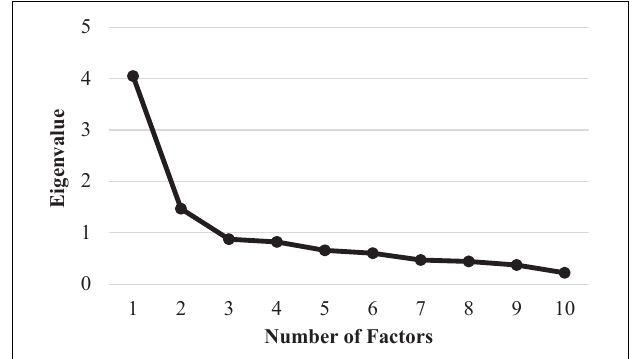
FIGURE 2 | Scree plot from EFA with maximum likelihood robust estimator and oblique geomin rotation based on dataset 1 ( n =